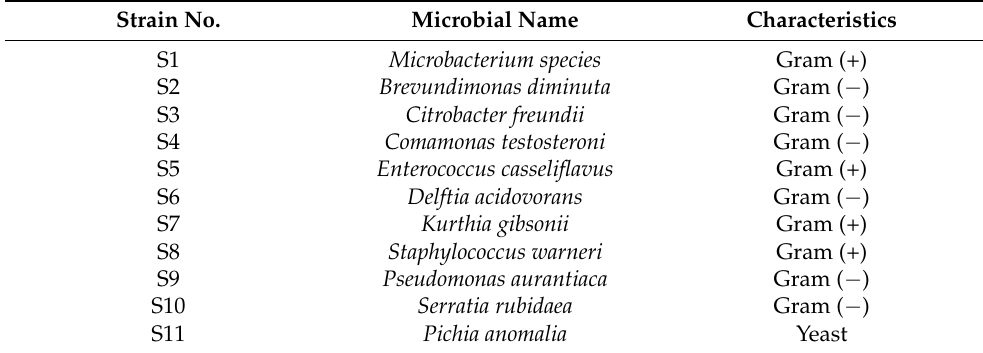
Table 1. Microorganism applied in MARA. Strain